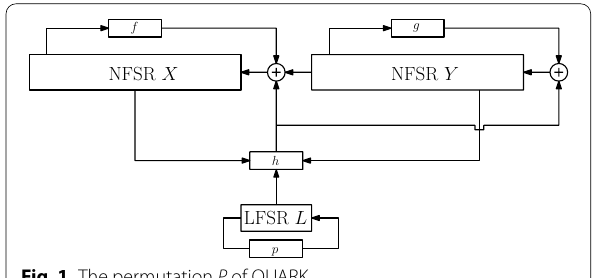
Fig. 1 The permutation P of